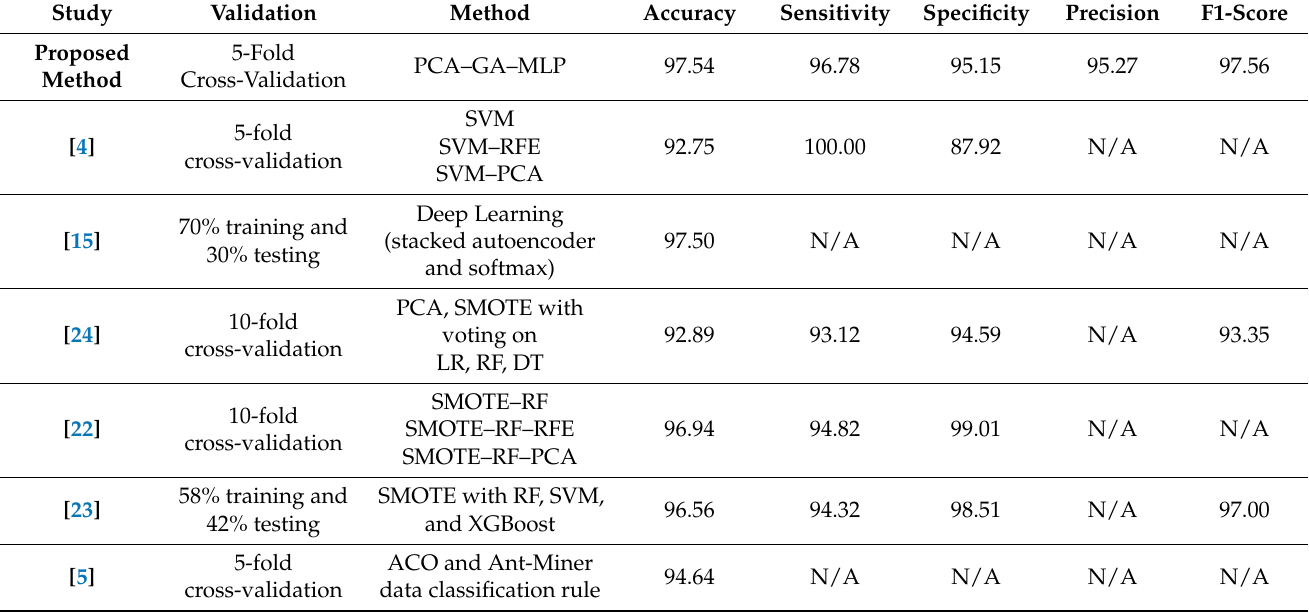
Figure 5. Comparison of the proposed method using four feature selection methods to diagnose Cytology. Table 10. Comparison of the proposed method with the best results in the literature in diagnosing